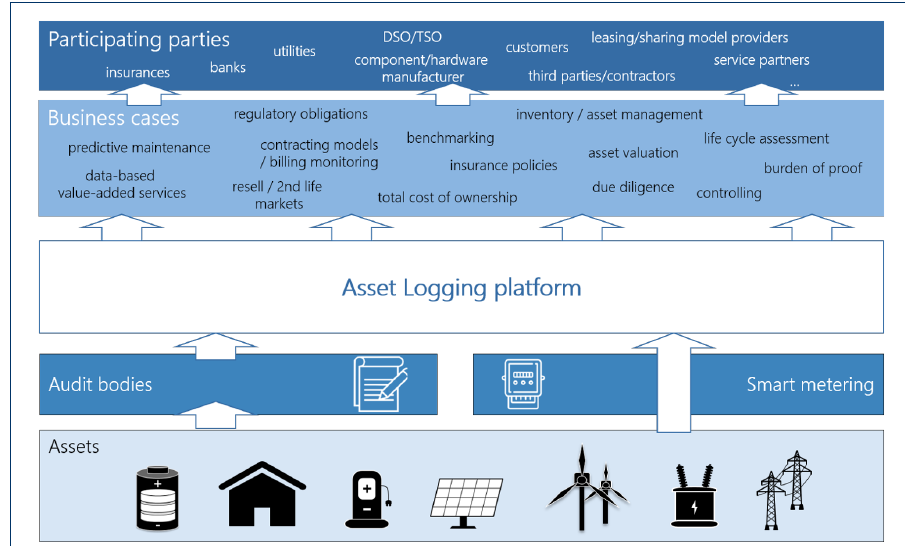
Figure 1 Schematic illustration of an Asset Logging